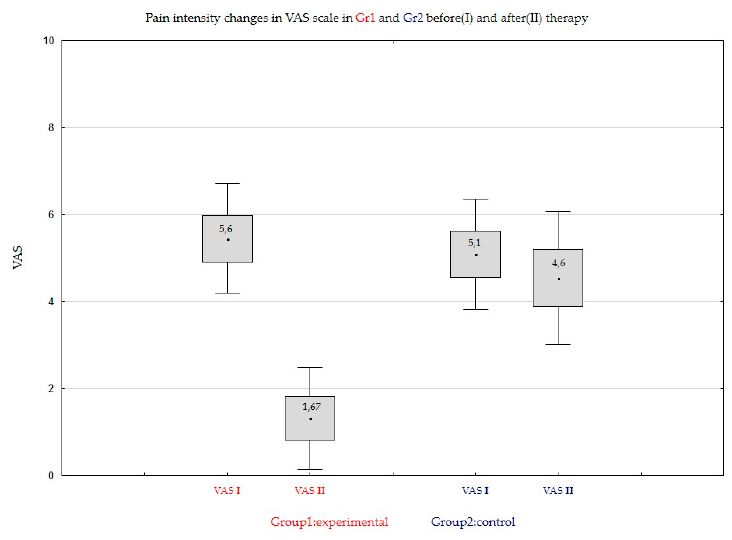
Figure 5. Pain intensity changes in VAS scale in Group1 and Group2 on Day0 (I) and on Day 14 (II) of the therapy.